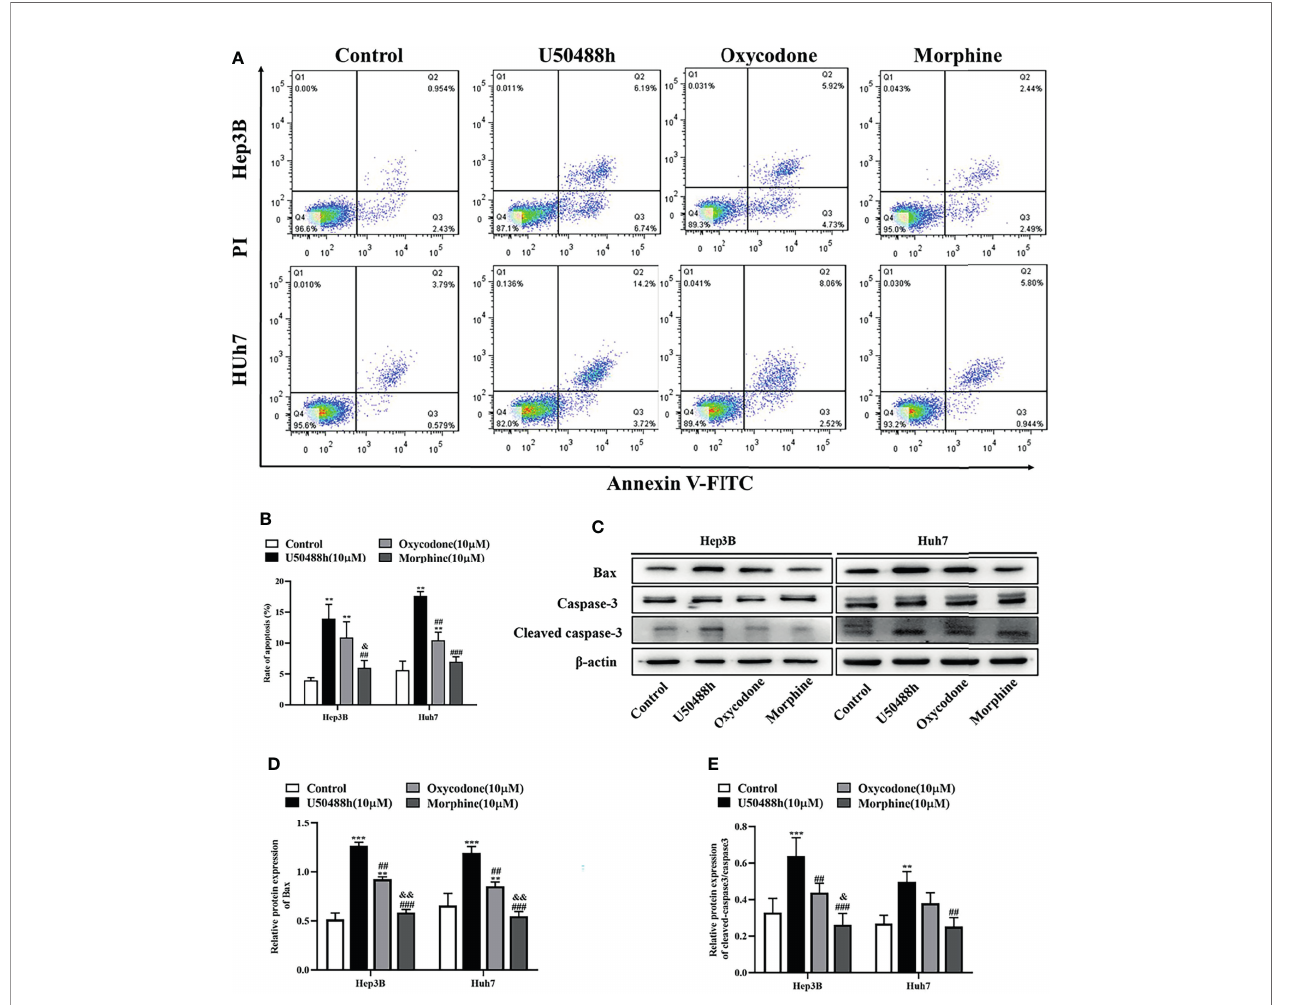
FIGURE 4 | KOR agonist induces apoptosis in HCC cells. (A) Hep3B and Huh7 cells were exposed to 10 m M U50488h, 10 m M oxycodone and 10 m M morphine for 48 h using PI/Annexin V-FITC fl ow cytometry. (B) Histogram indicates the rate of apoptosis of cells. (C – E) Cells were cultured with 50 m M U50488h, 10 m M oxycodone and 10 m M morphine for 48 h, and the expression of apoptosis-related proteins such as Bax and Cleaved caspase-3 were analyzed by western blotting. b -actin was used as an internal control. Values are reported as the mean ± standard deviation (n = 3). **P < 0.01, ***P < 0.001 vs. control group; ## P < 0.01, ### P < 0.001 vs. U50488h group; & P < 0.1, && P < 0.01 vs. oxycodone group. PI, propidium iodide; FITC, fl uorescein